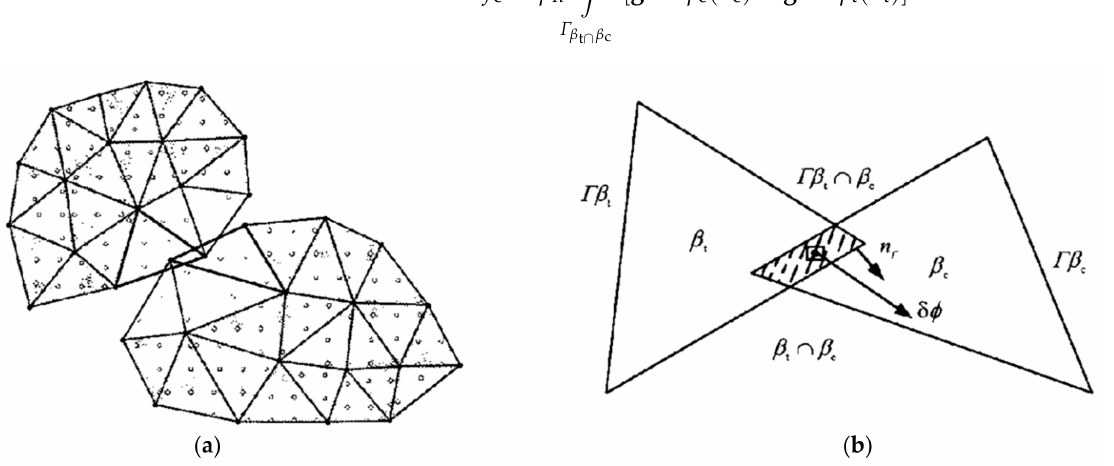
Figure 3. ( a ) Discretization for the contact between blocks with arbitrary shape; ( b ) contact between triangular elements